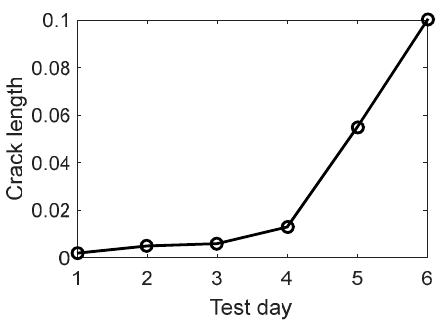
Figure 19. The crack growth behavior of fatigue experiment conducted at the NAVAIR facility.